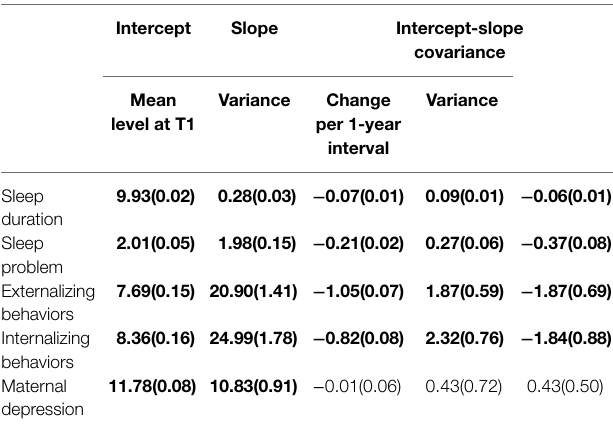
TABLE 3 | Results of univariate growth curve